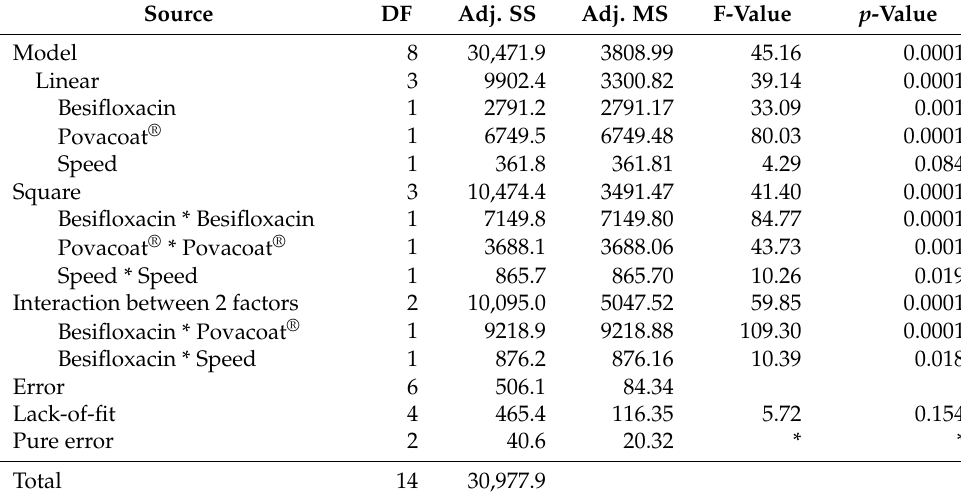
Table 3. Analysis of variance to test the significance of the terms obtained for the particle Z-ave variation of the besifloxacin nanocrystal preparations. The variables are besifloxacin concentration (wt%), Povacoat ® concentration (wt%), and velocity (rpm).